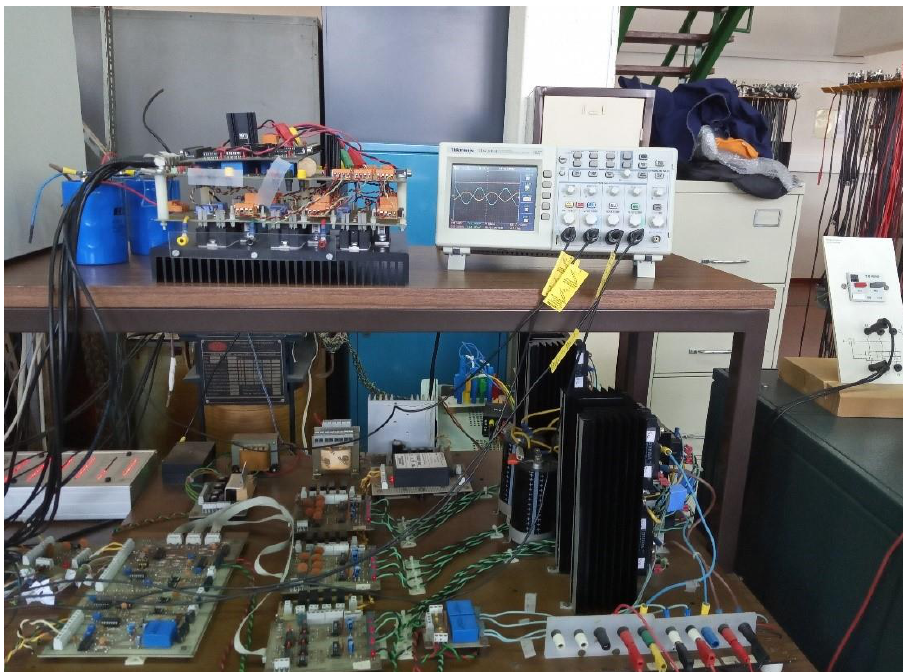
Figure 13. Picture of the lab prototype of the experimental system.